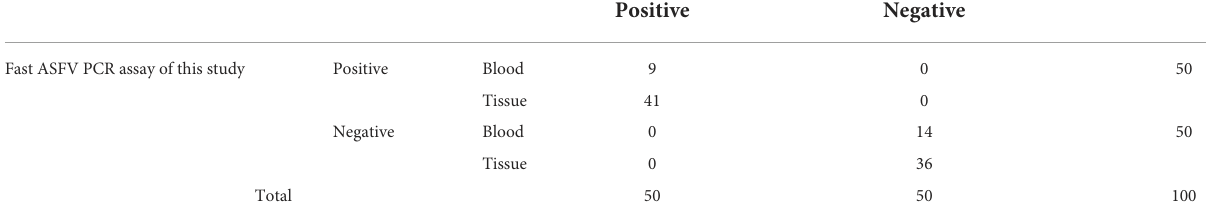
TABLE 8 Agreement with Fernández-Pinero method (UPL-162